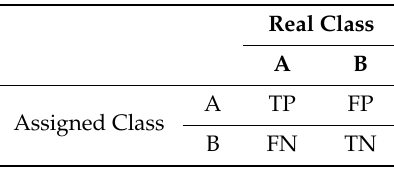
Table A1. Confusion